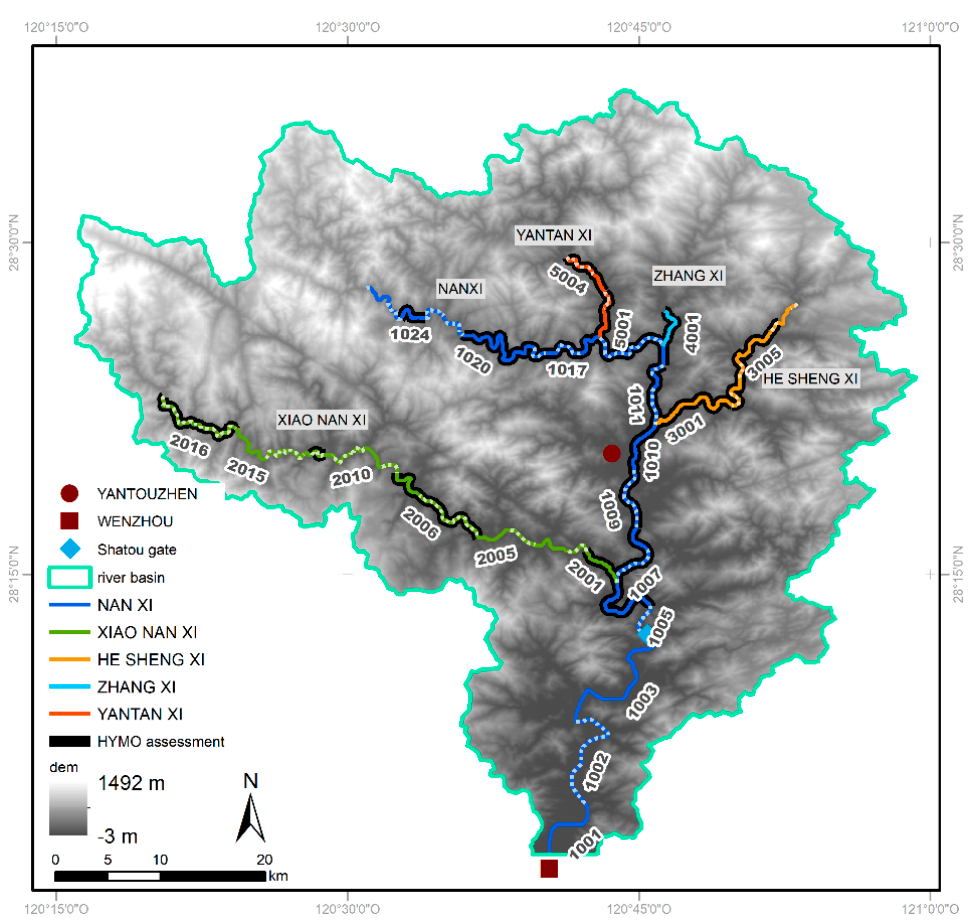
Figure 3. Results of the spatial delineation of the river system: fifty-six reaches assigned to five streams within the Nanxi river basin. Thirty-two reaches were selected for further investigations. Table 1. Adapted set of parameters: twelve parameters, observation units, classifications, threshold values, and related